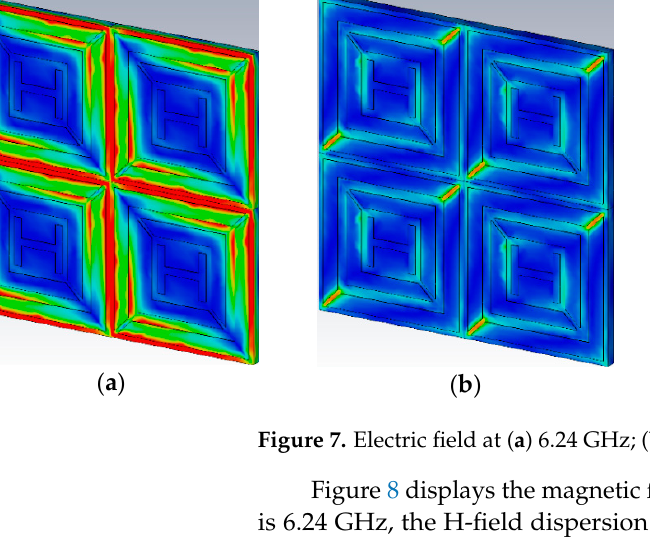
Figure 6. ( a ) Equivalent circuit; ( b ) S